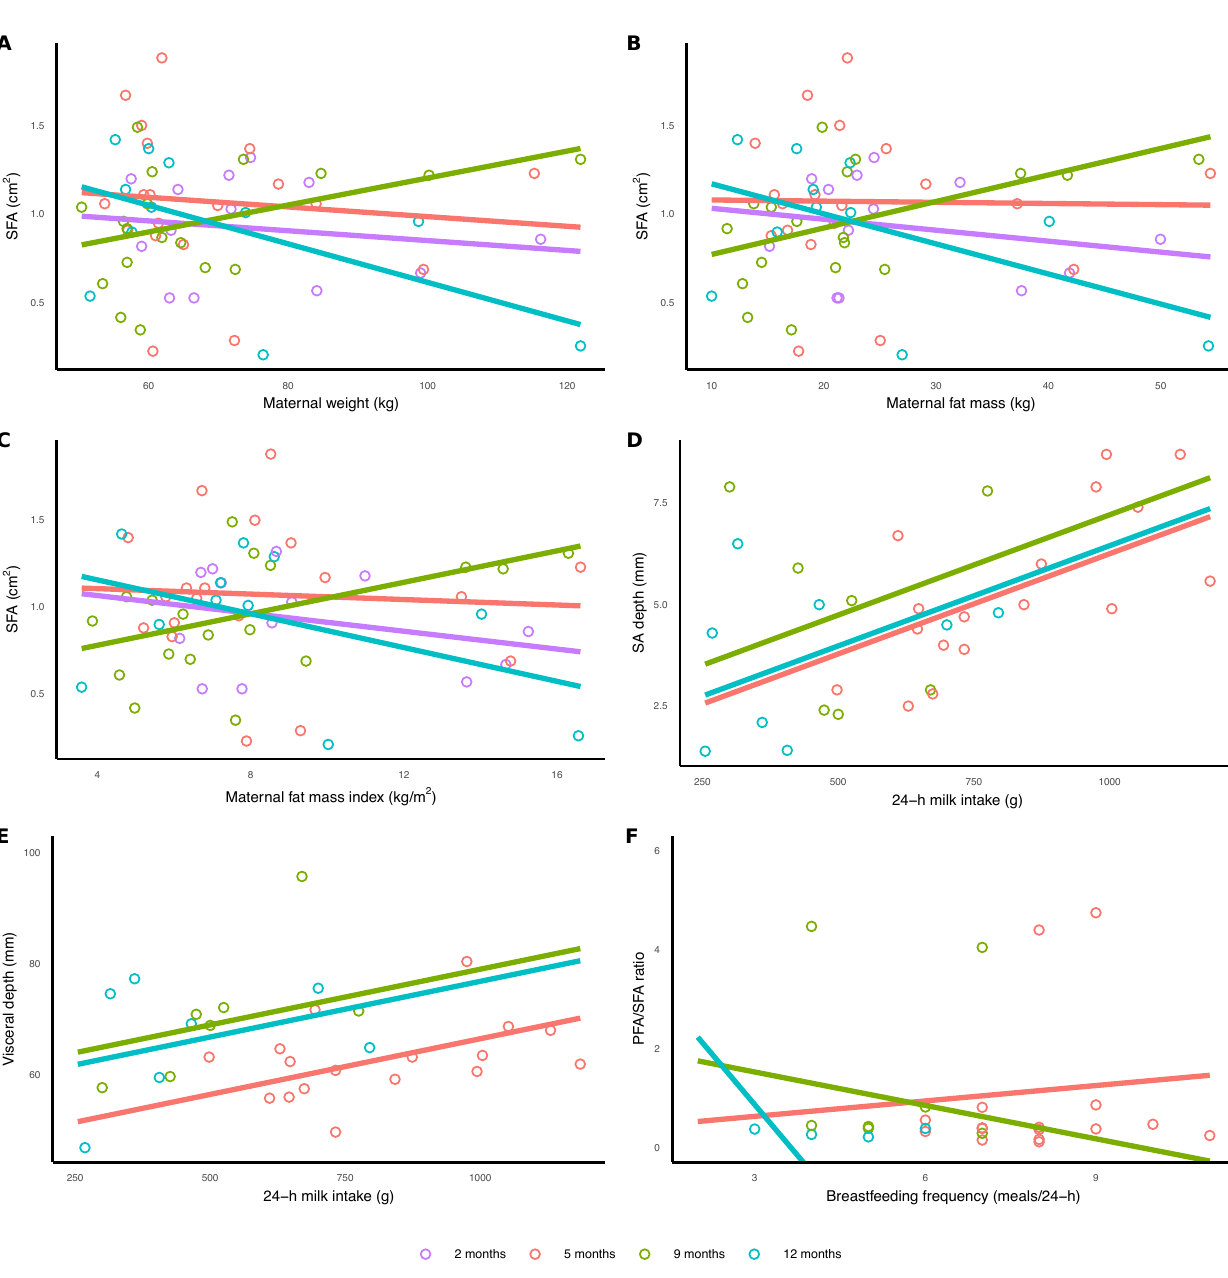
Figure 2. Significant associations between infant subcutaneous fat area (SFA) and ( A ) maternal weight ( p = 0.020), ( B ) mater- nal fat mass ( p = 0.010) and ( C ) fat mass index ( p = 0.023); 24h milk intake and ( D ) subcutaneous-abdominal ( p = 0.007) and ( E ) visceral ( p = 0.013) depths; and ( F ) breastfeeding frequency and peritoneal fat area to subcutaneous fat area ratio (PFA/SFA, p = 0.002). Lines represent linear regression and grouped by the month of